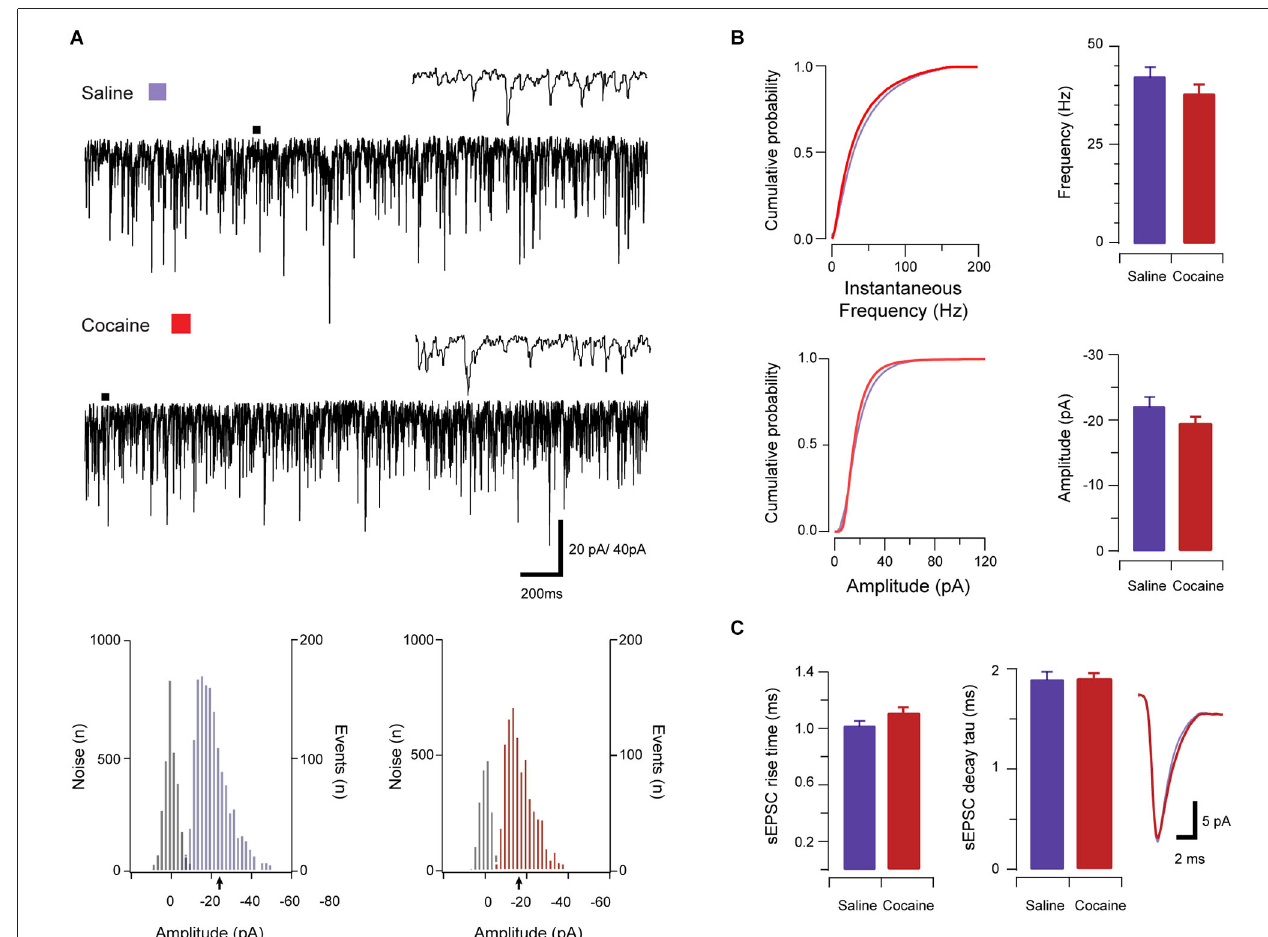
(from representative recordings) and bar graphs showed no differences in both instantaneous frequency ( B, upper ) and amplitude ( B, lower ) of aPVT neurons in response to saline or cocaine. Group data plots ( C ) show rise time and decay time constant remained similar in both saline and cocaine treatment groups ( n = 25 and n = 24, with an average of 1387 events and 1192 events analyzed respectively), with representative traces of rise and